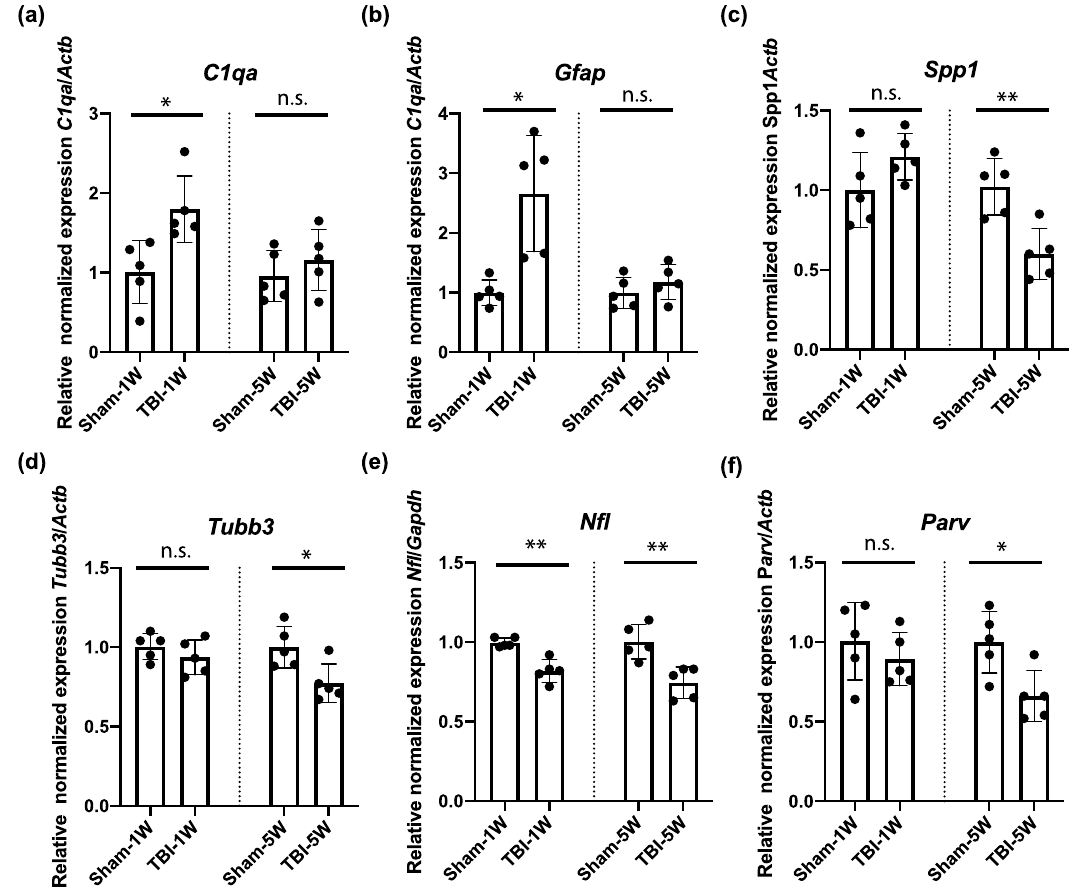
Figure 4. bTBI-associated changes in transcript levels observed by RNA sequencing confirmed by quantitative reverse transcription PCR of a subset of affected transcripts. Relative expression of ( a ) C1qa , ( b ) Gfap , ( c ) Spp1 , ( d ) Tubb3 , ( e ) Nfl, and ( f ) Parv normalized to the level of Actb or Gapdh , as indicated, at 1 week (1 W) or 5 weeks (5 W) and also normalized to the mean of the sham for that time-point. Bars represent mean ± SD and each data point represents a biological sample (n = 5 per group); unpaired two tailed t -test analysis with Welch’s correction: * p < 0.05, ** p < 0.01 and n.s. not significant. The graphs were generated in Prism 8 software and the figure was assembled in Adobe Illustrator CC